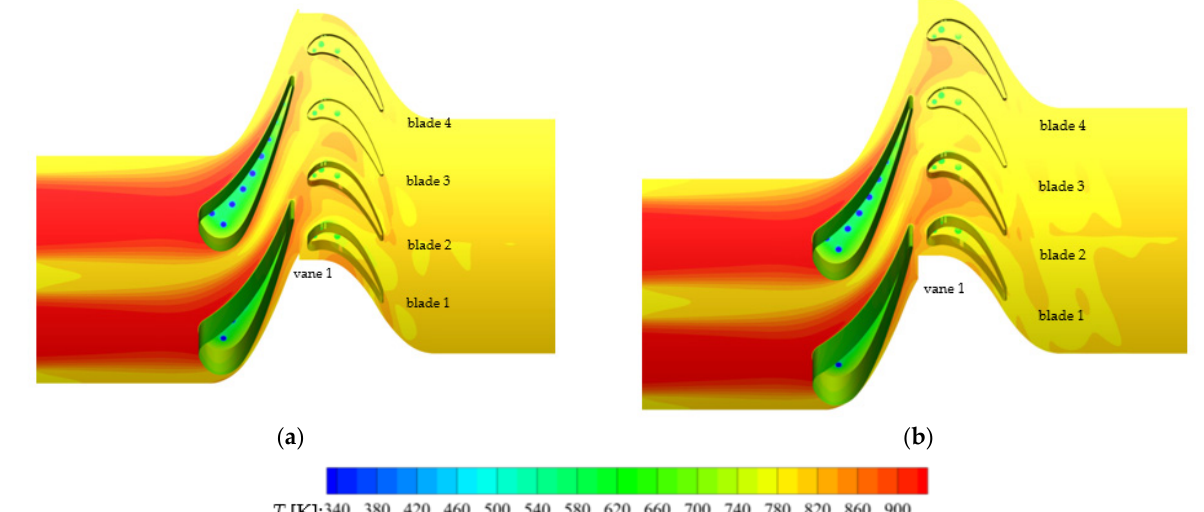
Figure 7. Total temperature distribution in the mid-span. ( a ) At t = 0/4 T ; ( b ) at t = 1/4 T .